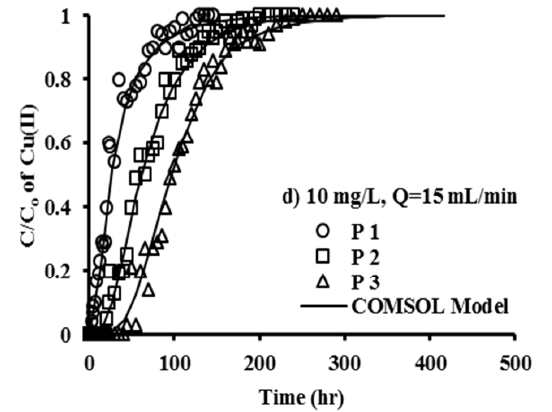
Fig. 6. Comparison between model predictions and experimental measurements for the normalized concentration of cadmium and copper under the effects of flow rate and bed depth.